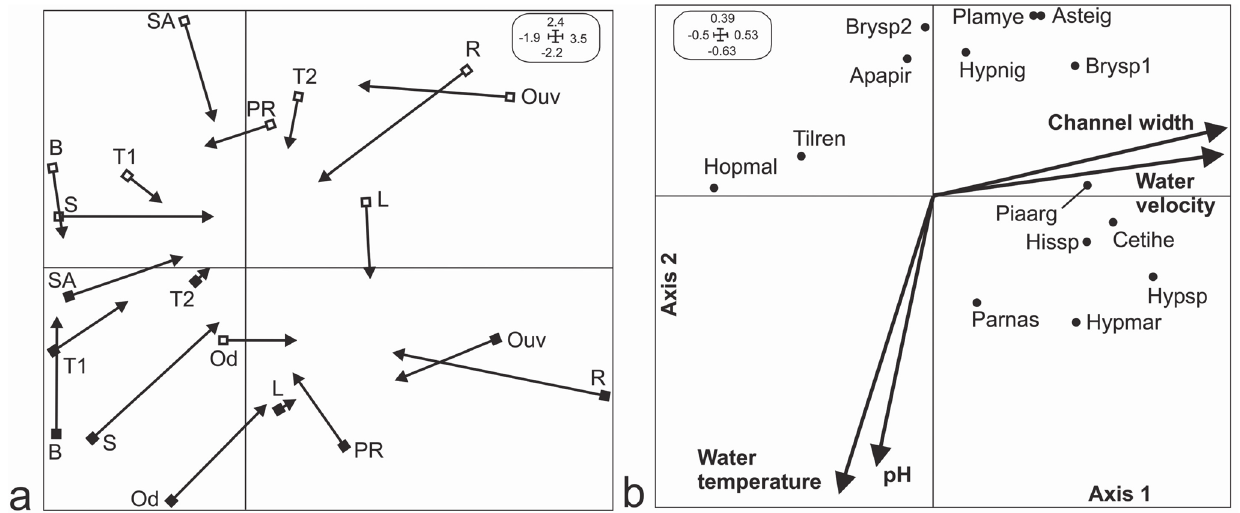
Fig. 2. Ordination of the co-structure between (a) fish assemblages (arrows) and stream sites (squares) and (b) fish species and environmental variables resulting from the co-inertia analysis. Only species that most contributes to each axis are displayed. Black and white squares represent stream sites sampled in the wet and dry season, respectively. Codes correspond to names listed in Tables 1 and 2. Small boxes indicate the graphic scale. Table 5. Averages values of the quantitative variables by stream and season. DS = dry season; WS = wet